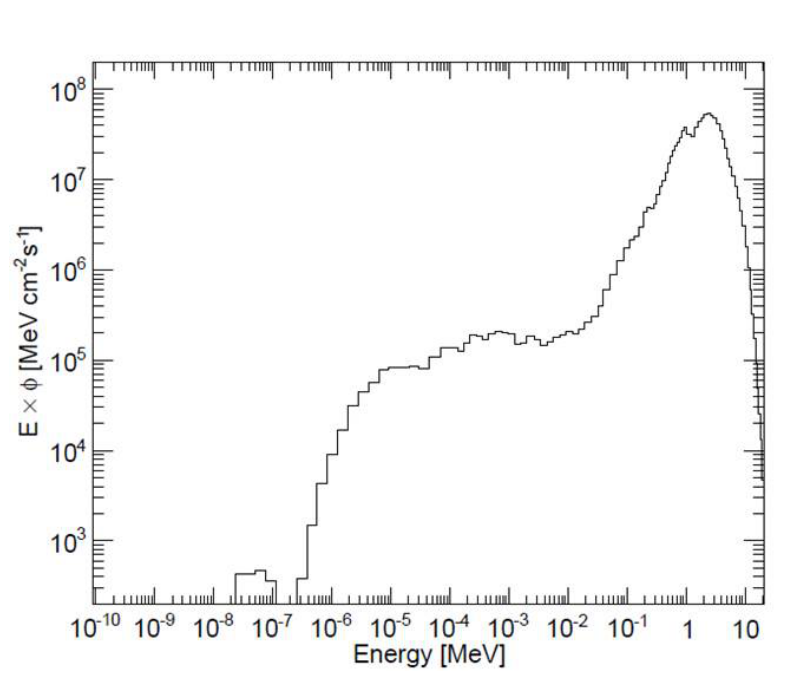
Figure 2: Neutron energy spectrum of the SR10 beam line at FRM II with FaNGaS collimators installed.